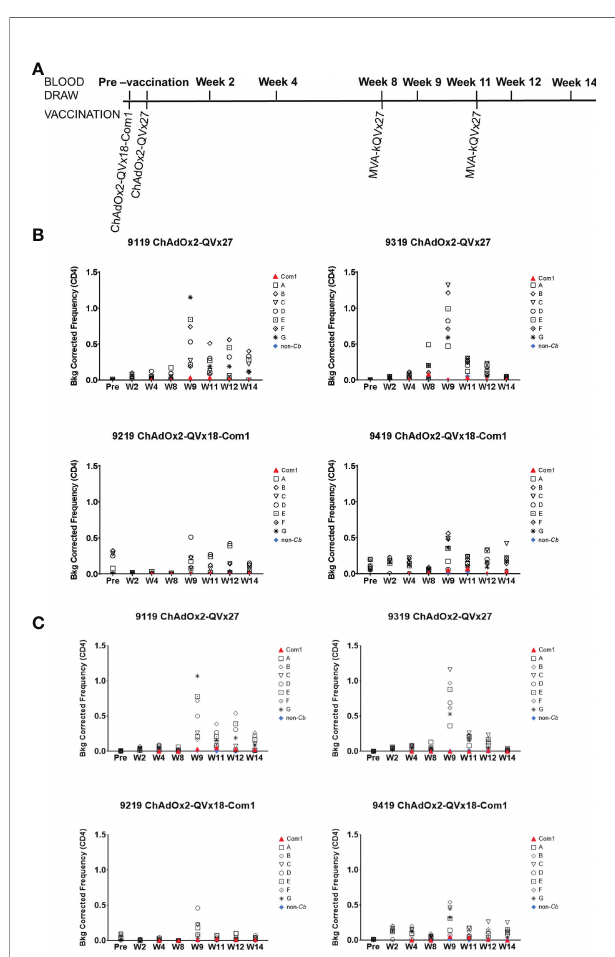
FIGURE 6 | Ex vivo CD4 + T cell recall responses to vaccine epitopes in vaccinated cynomolgus macaques. (A) Schedule of activities for nonhuman primate vaccine immunogenicity study. Cynomolgus macaques received prime vaccinations in Week 0 using the indicated ChAdOx2 vaccine constructs (1x10 9 IU/vaccination, delivered IM) (n = 2 for each vaccine construct). All animals received MVA-kQVx27 boost vaccinations (1x10 8 IU/ vaccination, delivered IM) at Weeks 8 and 11. Animals 9119 and 9319 received ChAdOx2-QVx27 prime vaccination. Animals 9219 and 9419 received ChAdOx2-QVx18-Com1 prime vaccination. (B, C) PBMCs from individual animals were stimulated ex vivo by the indicated epitope peptide pools (A-G, see Methods), a pool of peptides representing the full Com1 protein sequence, a short concatemer of non- Coxiella peptide sequences (non- Cb ), or no peptide. T cell activation status following peptide stimulation was evaluated by fl ow cytometry. Study time points are indicated on the X axis (Pre, pre-vaccination; W, Week). The frequencies of (B) CD4 + IFN g + or (C) CD4 + CD154 + IFN g + T cells are shown as a percentage of total CD4 + T cells (Y axis). Data shown are background corrected (peptide stimulated minus unstimulated). Individual macaque identi fi cation numbers and prime vaccine are noted in each graph